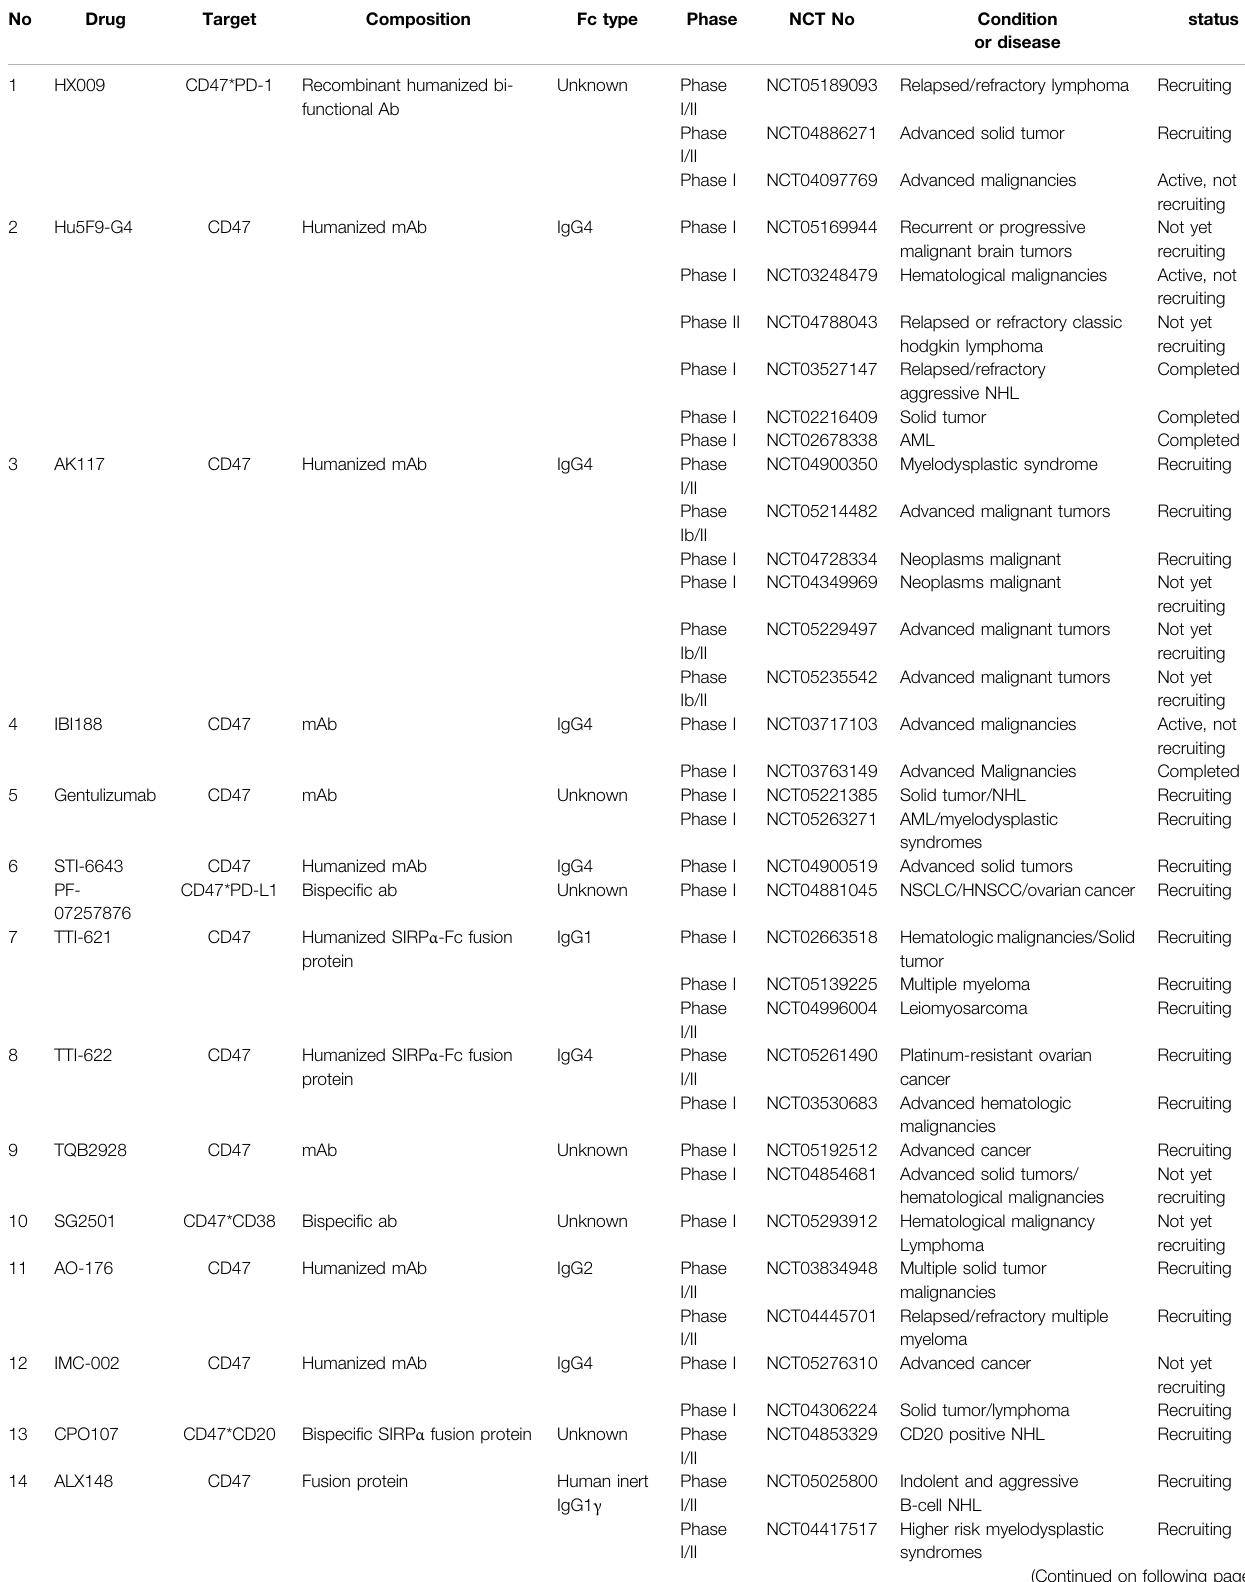
TABLE 1 | List of anti-tumor clinical trials targeting CD47-SIRP α